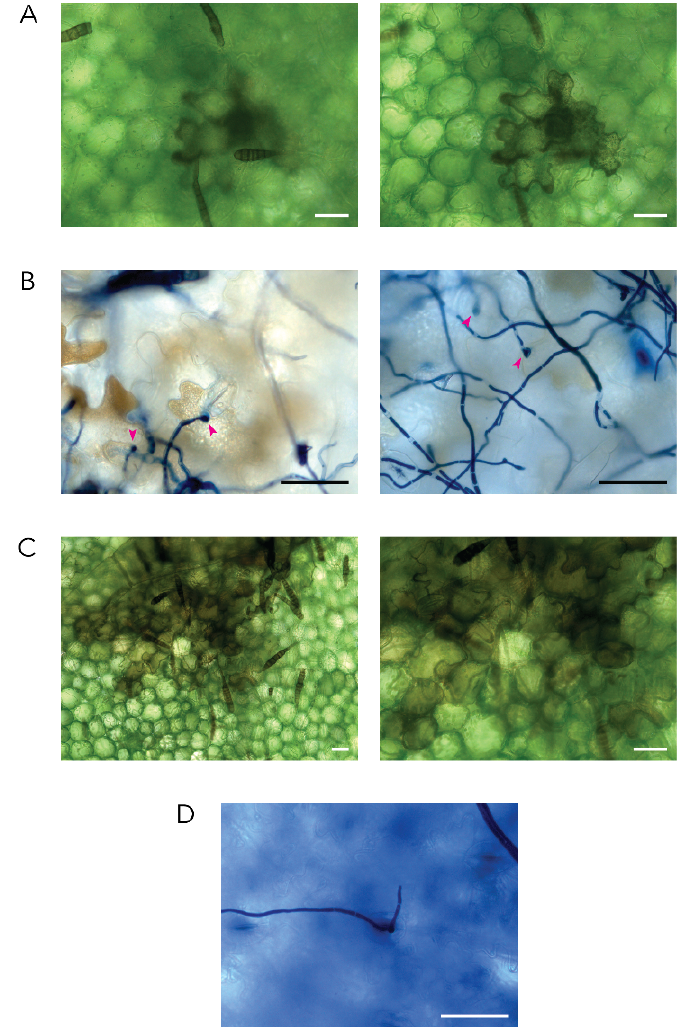
Figure 2. Infection of potato by A. solani . Representative micrographs of ( A ) death of a potato adaxial epidermal cell due to A. solani infection as observed in perfluorodecalin prepared samples harvested at 24 hpi. ( B ) Appressoria formed by A. solani to penetrate the adaxial side of the leaf at 24 hpi as observed in trypan blue stained samples harvested at 24 hpi. Appressoria are indicated with a pink arrow. ( C ) Adaxial epidermal and mesophyll cell death due to A. solani as observed in perfluorodecalin prepared samples harvested 48 hpi. ( D ) Emergence of A. solani hyphae through a stoma on the abaxial side of the leaf as observed in trypan blue stained samples harvested at 48 hpi. Scale bars in all images correspond to 50 µm.